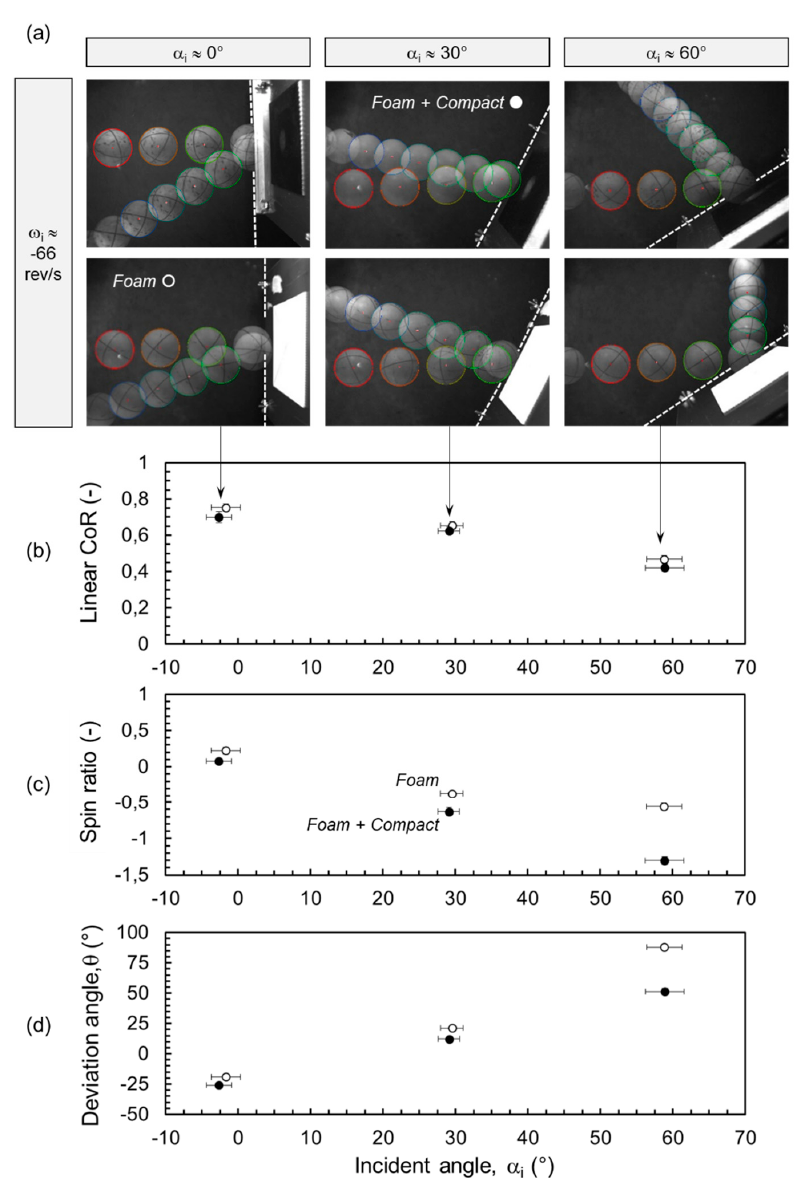
Figure 5. ( a ) Raw images of impact tests performed on the foam + compact and foam samples with varying incident angle ( (cid:107) V i (cid:107) = 14 m/s, T amb ). ( b ) Linear coefficient of Restitution as a function of the incident angle. ( c ) Spin ratio as a function of the incident angle. ( d ) Deviation angle as a function of the incident